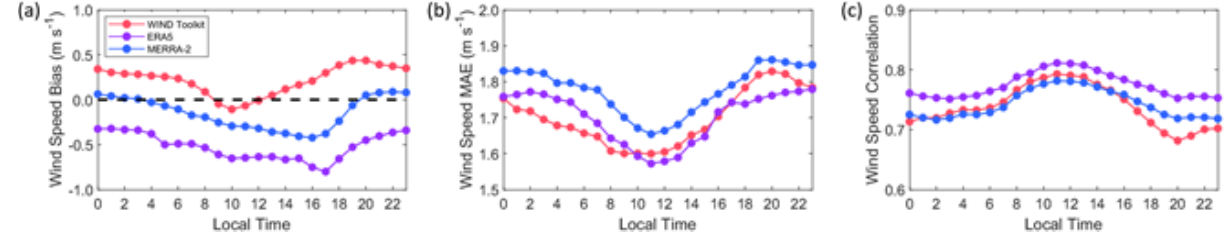
Figure 4. Average diurnal wind speed (a) bias, (b) MAE, and (c) correlation across 62 sites at heights ranging from 10 to 50m using distance-weighted horizontal interpolation.